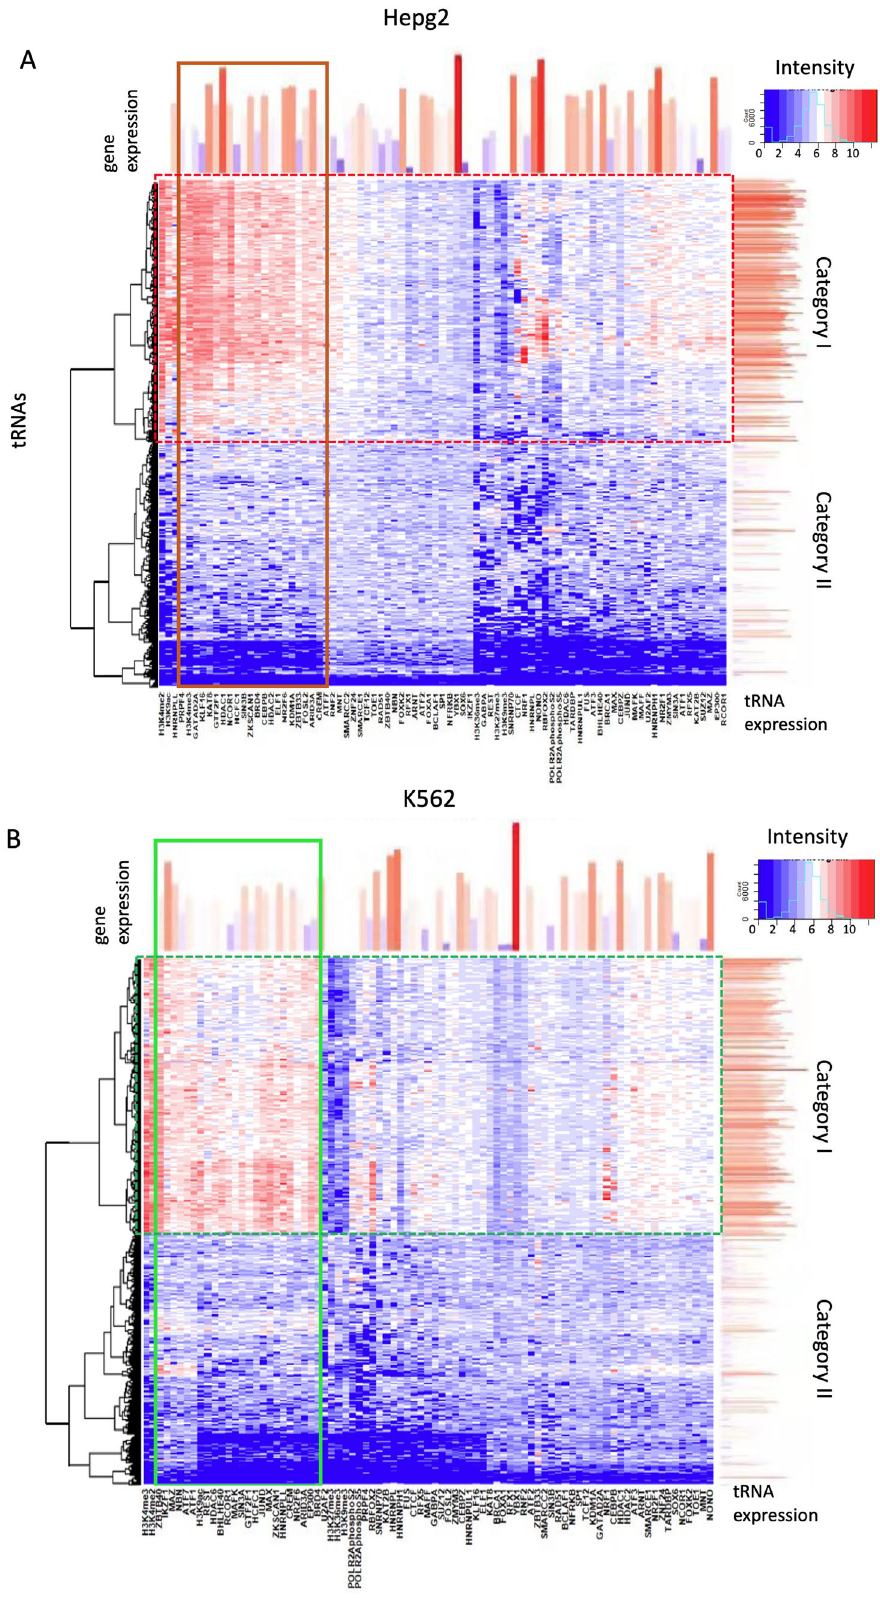
Figure 1. ChIP-Seq matrixes of tRNA genes in HepG2 and K562 cells. ( A , B ) ChIP-Seq profiles of 83 DBPs and six histone modifications of tRNA genes in HepG2 and K562 cells, respectively. The red blocks in the matrices indicate higher binding intensities of DBPs or enrichment of histone markers. The red bar charts at the top and right side of the matrixes represent the abundance of DBPs and tRNAs, respectively. The solid red and green rectangles indicate the top tRNA gene-binding proteins in HepG2 and K562 cell lines, and the dotted red and green rectangles highlight category I tRNAs in the two cell